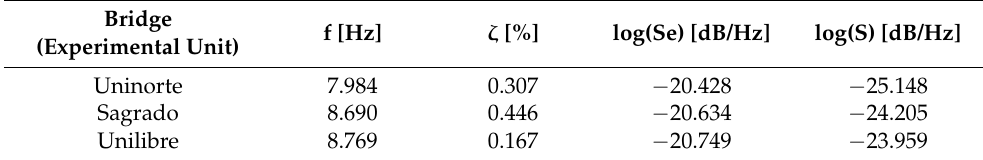
Table 8. Fitted frequencies associated with the first four vertical vibration modes in [Hz]. Table 6. Average curve fitting results for each bridge.